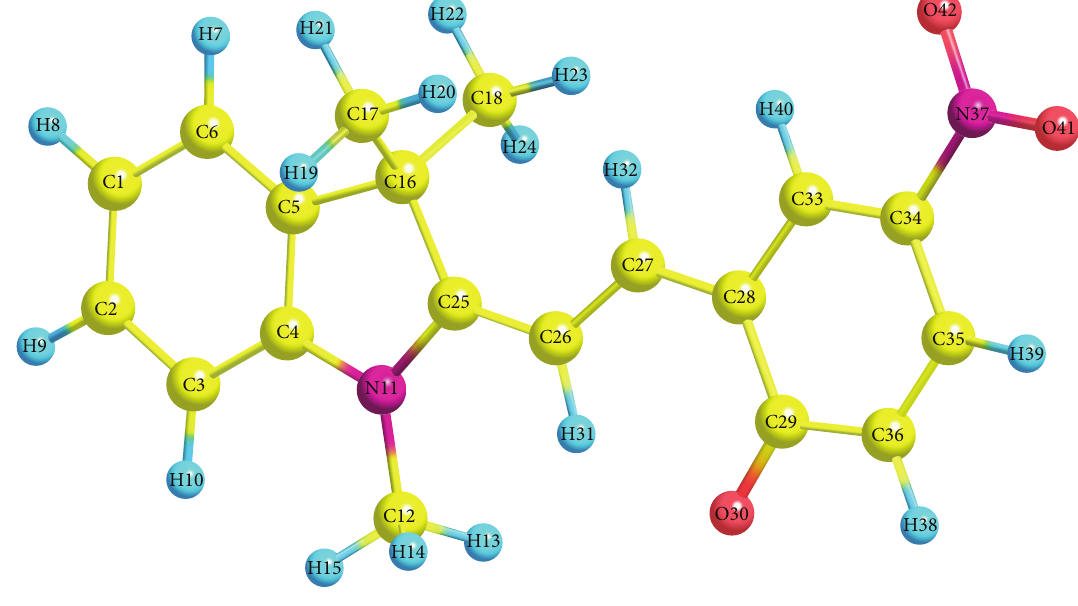
Figure 2: General structure of the merocyanine.